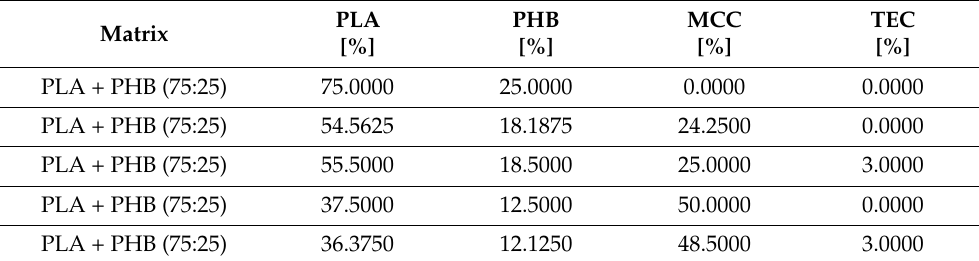
Table 1. Composition and shortcode for every elaborated biopolymer blend.